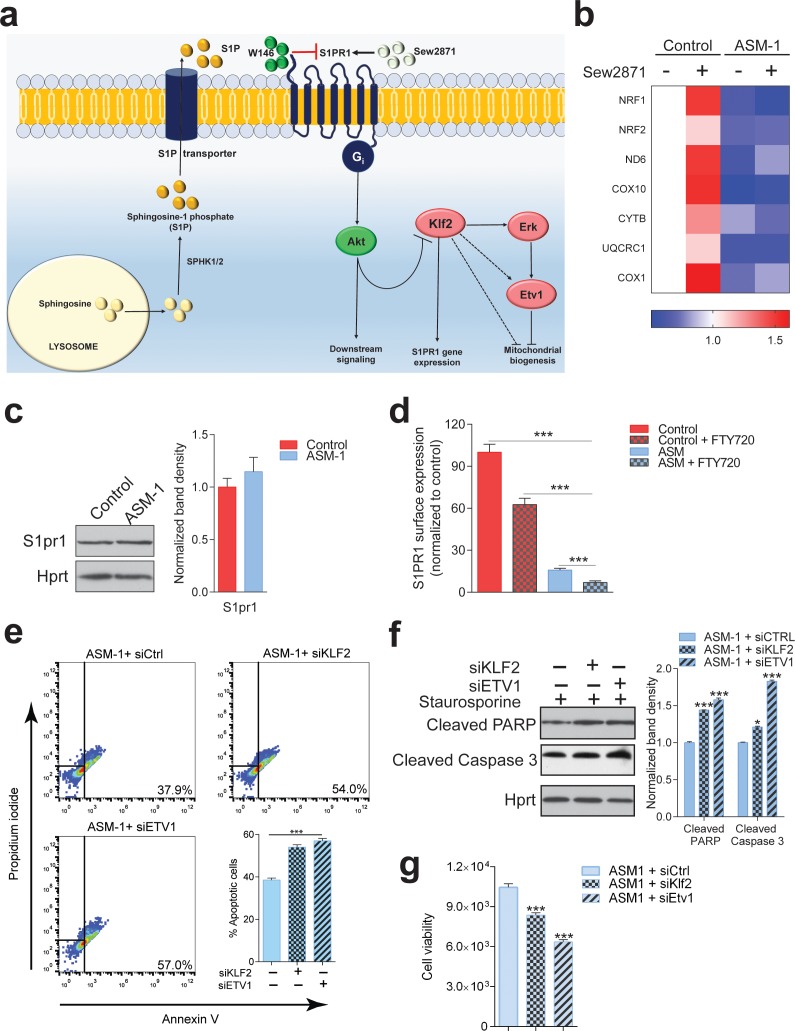
S1PR1 signaling in Niemann-Pick disease.(a) Schematic illustration of sphingosine-1-phospate (S1P) signaling. S1P is generated from sphingosine by the kinases SPHK1 (plasma membrane) and SPHK2 (endoplasmic reticulum and mitochondria), and can be transported out of the cell. Extracellular S1P can activate several receptors (S1PR1-5). Specifically, stimulation of S1PR1 triggers Akt signaling which regulates KLF2 levels. Expression of S1PR1 is regulated by KLF2, which as shown by our data also activates ETV1. Sew2871 is an agonist of S1PR1, and W146 is an antagonist. (b) Treatment of control fibroblasts with S1PR1 agonist Sew2871 (5 µM, 16 hr) results in increased transcript levels of mitochondria-related genes in control fibroblasts, but has no effect on ASM-deficient fibroblasts. The data is presented in a Heatmap for n = 3, in which blue denotes decrease in expression compared to the control cells (white represents no change relative to the control values) and red denotes increase. Note the mostly increased (red) mitochondrial genes in control fibroblasts treated with Sew2871, while blue in ASM fibroblasts regardless of the treatment. (c) Protein levels of S1PR1 are not changed in ASM fibroblasts, as measured by western blot using whole cell extracts. Adjacent plot shows the quantification presented as mean ± s.e.m., n = 3. T-test p-value>0.05. (d) Staining of S1PR1 present at the plasma membrane, in non-permeabilized cells, measured by flow cytometry. FTY720 triggers the endocytosis if S1PR1 and was used as a negative control for surface staining. Note the barely detectable surface S1PR1 levels. Plots represent the average fraction of S1PR1 levels normalized to vehicle treated control cells and depicted as mean ± s.e.m., n = 3. T.test p-value ***p<0.001 (e) Staurosporine-treated ASM-deficient cells with KLF2 and ETV1 silencing show increased apoptotic cell population relative to control ASM-deficient cells as measured by flow cytometry with Annexin-V and Propidium iodide staining. Quantifications are depicted as mean ± s.e.m., n = 5. T-test p-value ***p<0.001. (f) Staurosporine-treated ASM-deficient fibroblasts with either silencing control, KLF2 or ETV1 knockdowns show increased protein amounts of Cleaved PARP and Cleaved Caspase three levels in cells with KLF2 or ETV1 silencing and quantifications in adjacent graphs show mean ± s.em., n = 3. T-test p-value **p<0.01 and ***p<0.001. (g) Decreased cell viability as measured by Glo Titer Assay in ASM-deficient fibroblast with either KLF2 or ETV1 silencing. Plots represent mean± s.e.m., n = 2 with six technical replicates per condition. T-test p-value, ***p<0.001.